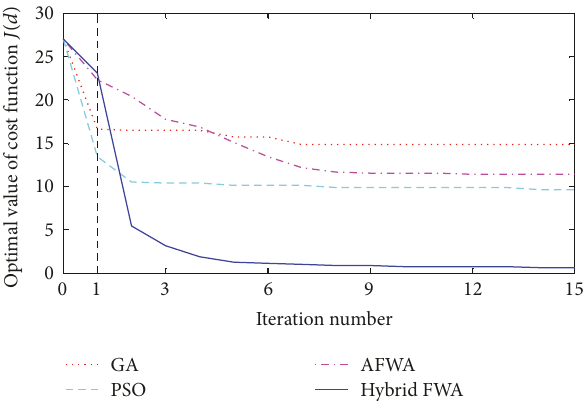
Figure 9: HV performance optimization using various algorithms.